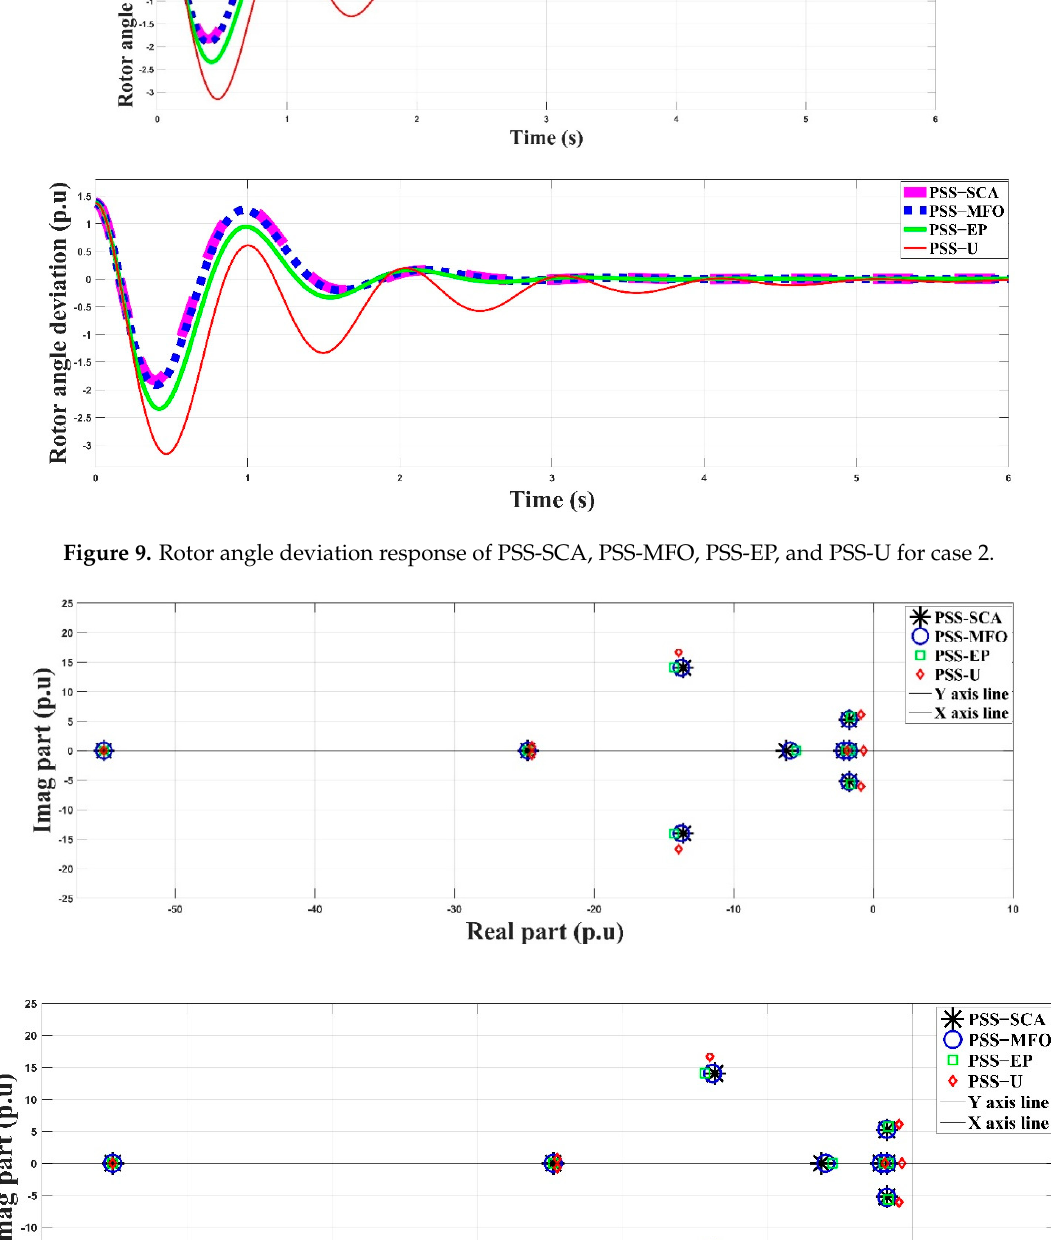
Figure 10. Eigenvalues distribution of PSS-SCA, PSS-MFO, PSS-EP, and PSS-U for case 2.